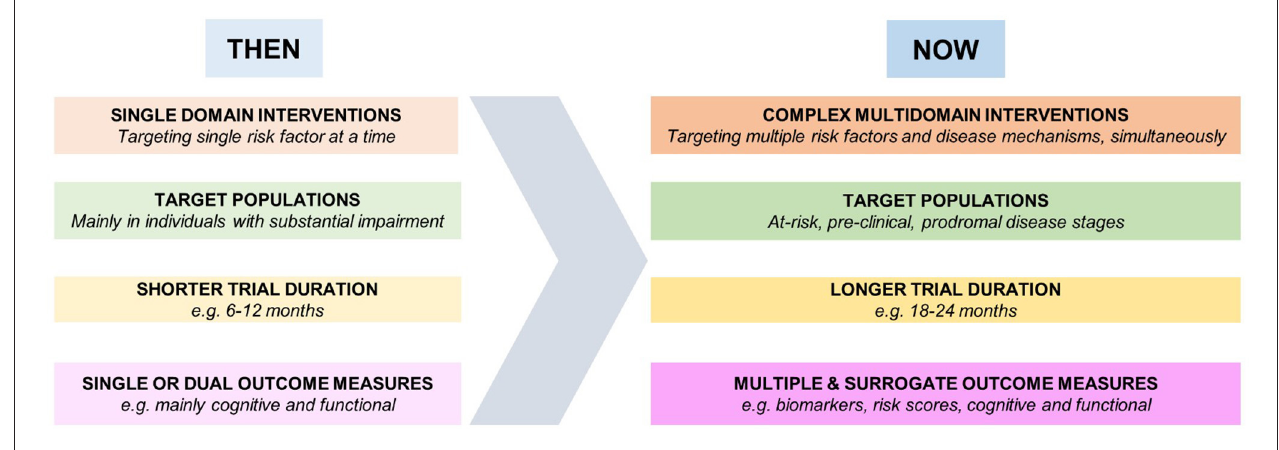
FIGURE 1 | Development of dementia risk reduction trials.